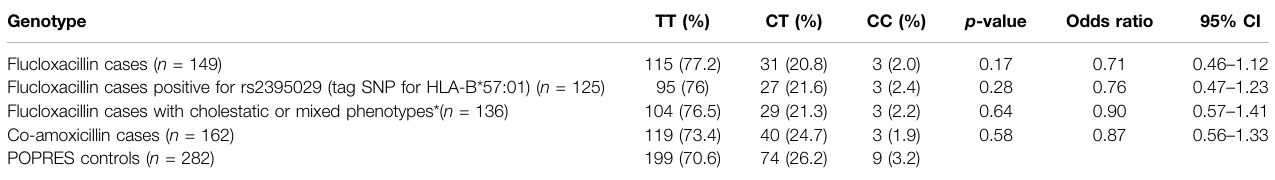
TABLE 2 | SLCO1B1*5 (rs4149056) genotyping results in both DILI cohorts compared to POPRES community controls. Genotype TT